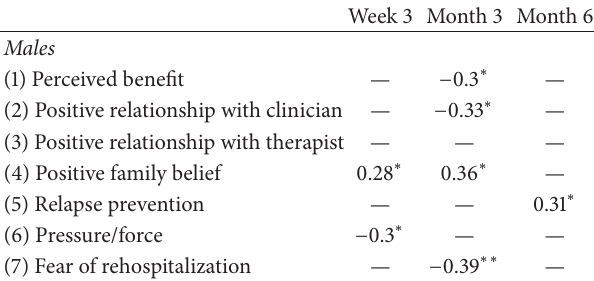
Table5:CorrelationbetweentheadherencetotreatmentandROMI items in